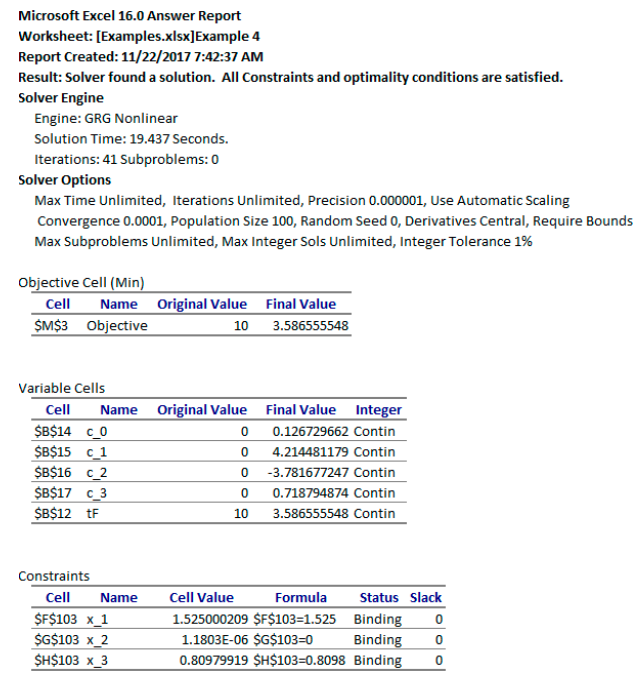
Figure 22. Answer Report generated by Excel’s Solver for optimal control problem (31)–(36).